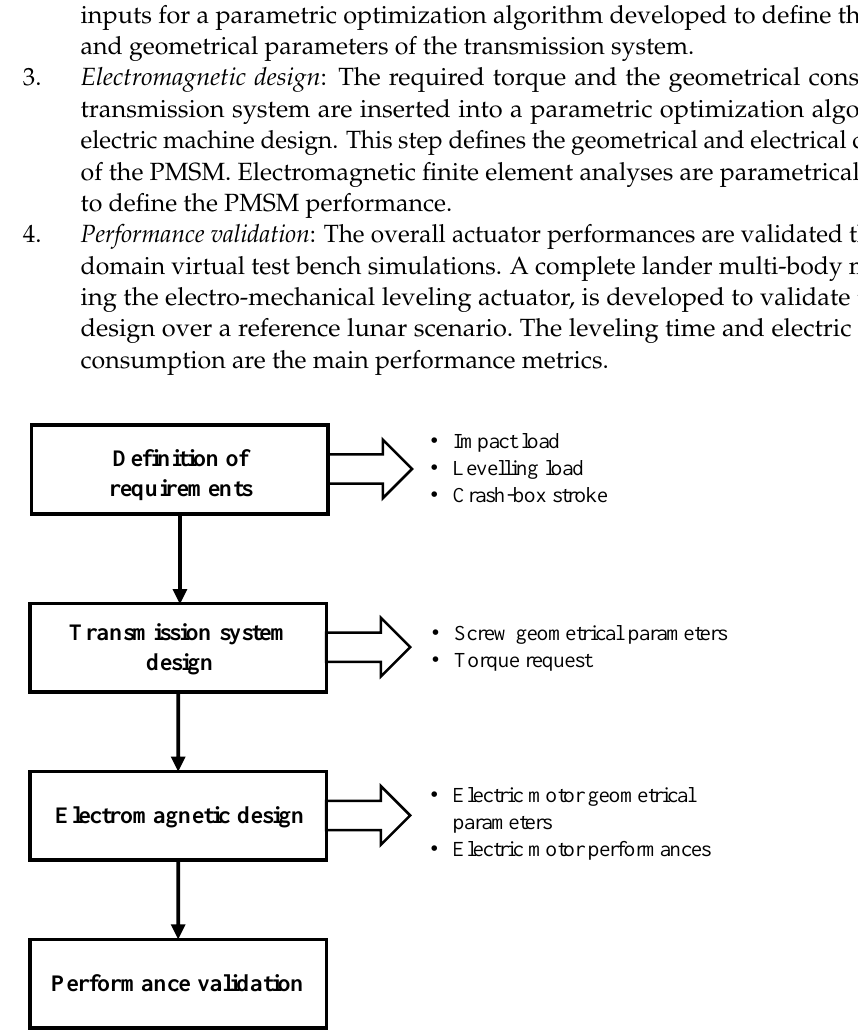
Figure 3. Design methodology